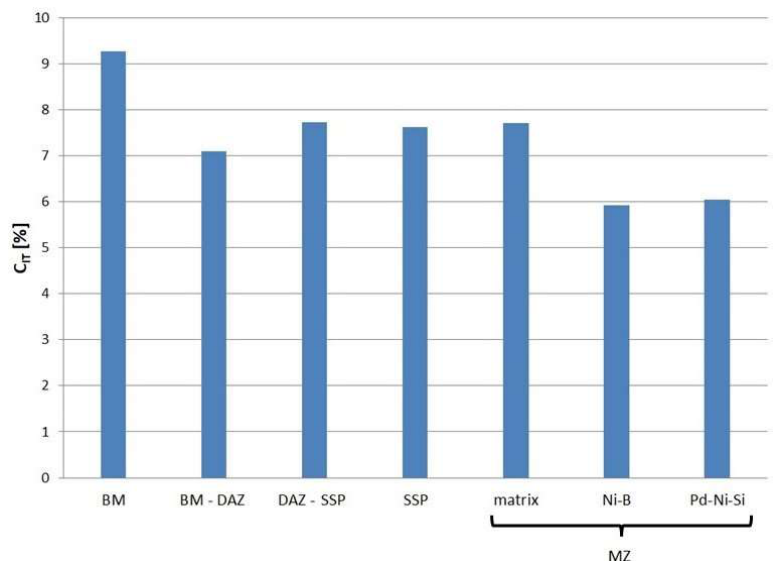
Figure 15. Indentation creep of structure elements in Hastelloy X–Palnicro 36M brazed joints.